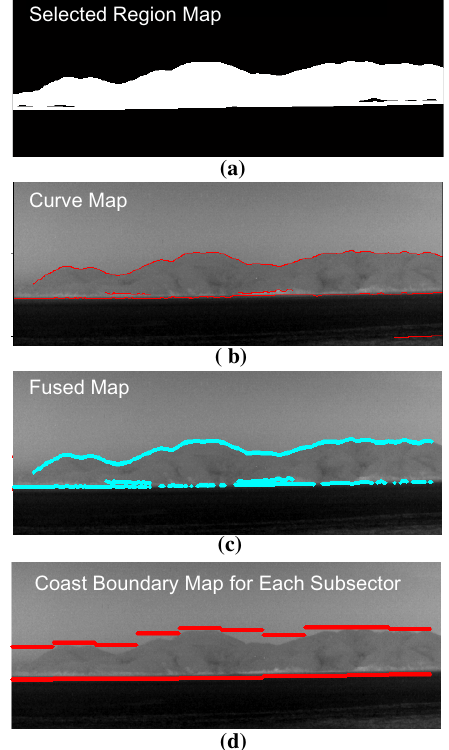
Figure 18. Fused map and coast boundary map generation flow using the selected region map and curve map: ( a ) selected region map using horizon information; ( b ) extracted curve map; ( c ) fused map generation by applying an AND operation to the selected region and curve map; ( d ) coast boundary representation.